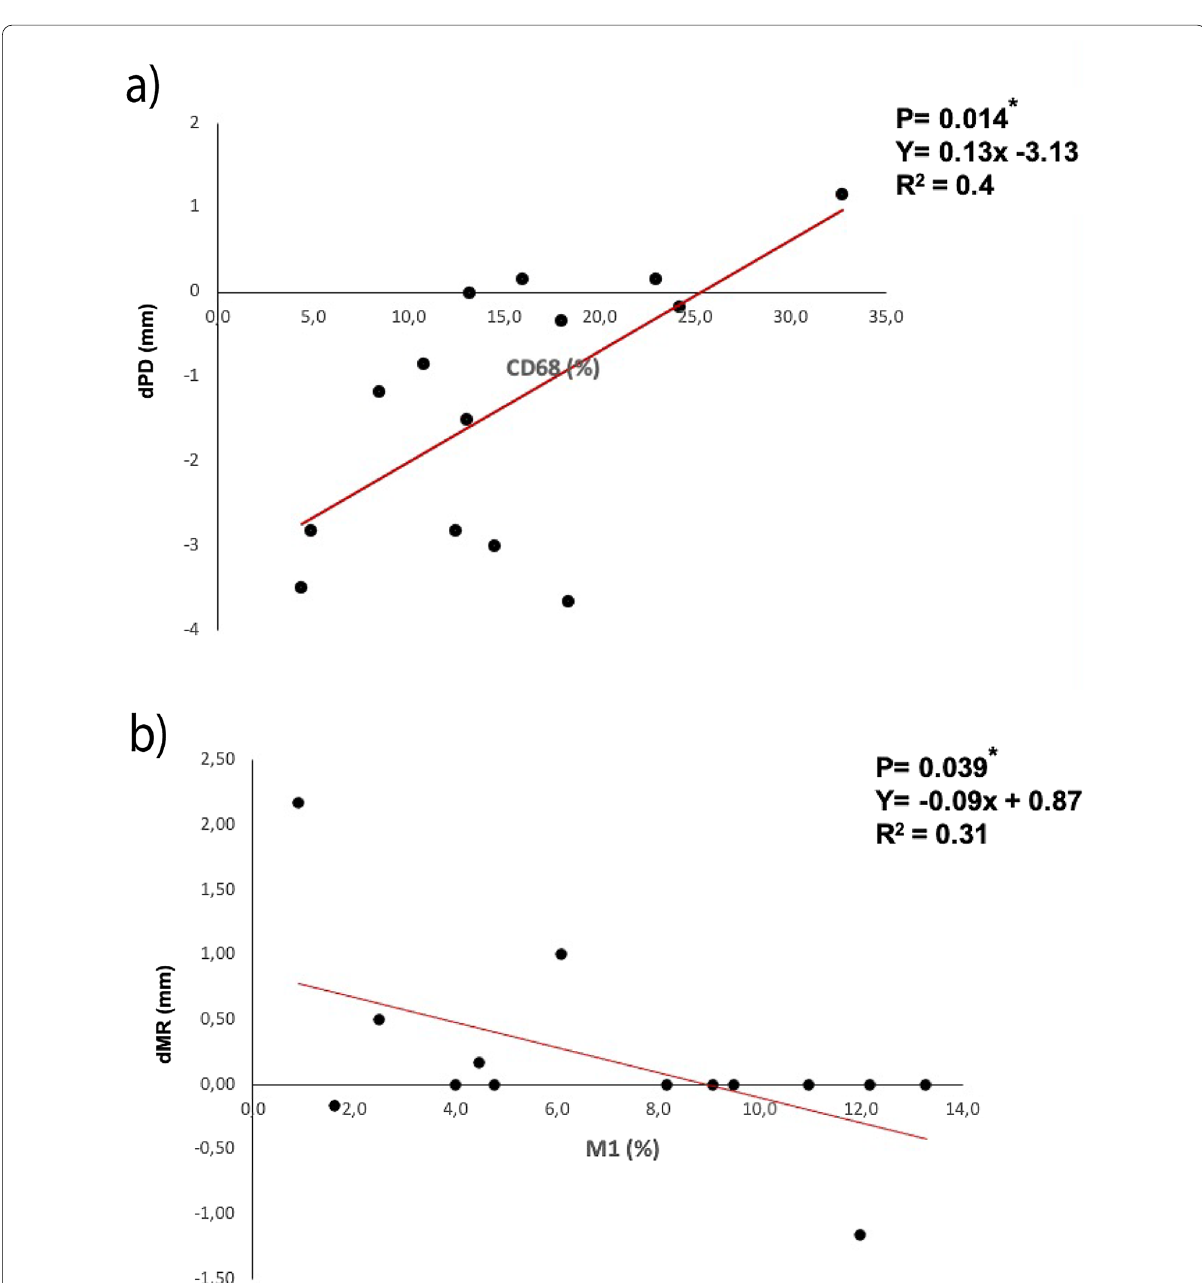
Fig. 3 Linear regression plots representing a significant correlation between: a macrophage expression (CD68%) and changes in PD scores and b M1 (%) expression and changes in MR scores. * p < 0.05 considered for statistical